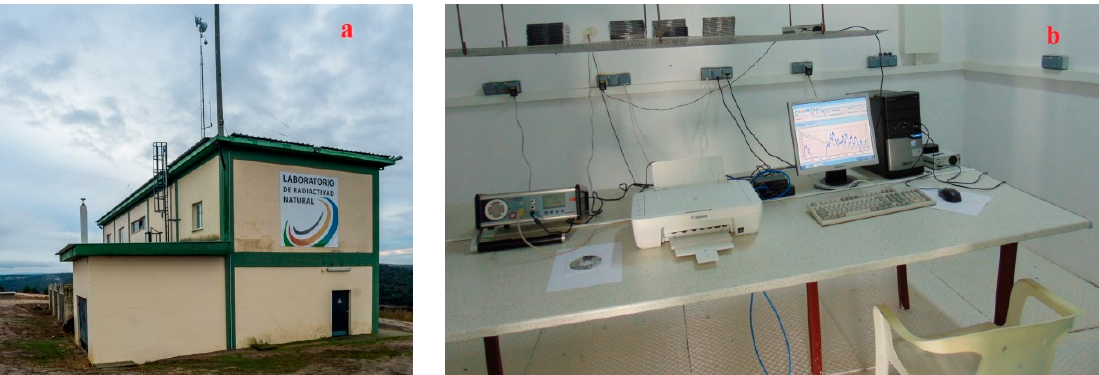
Figure 1. ( a ) Photos of the Laboratory of Natural Radiation ( b ) and the place in Room 1 where the experimental exposure was carried out.